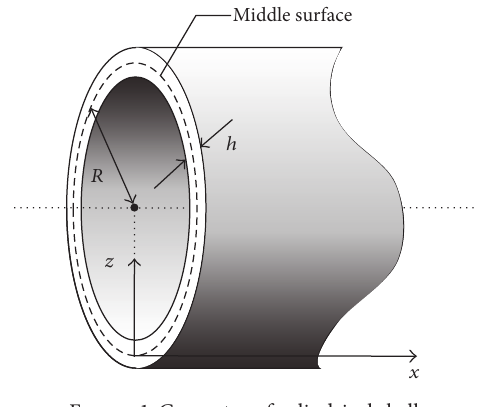
Figure 1: Geometry of cylindrical shell.